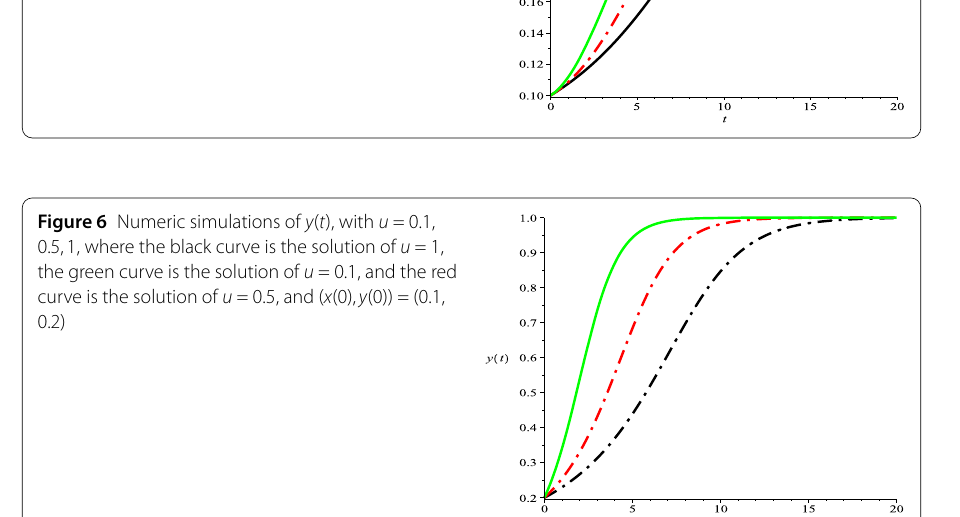
Figure 5 Numeric simulations of x ( t ), with u = 0.1, 0.5,1, where the black curve is the solution of u = 1, the green curve is the solution of u = 0.1, and the red curve is the solution of u = 0.5, and ( x (0), y (0)) = (0.1, 0.2)